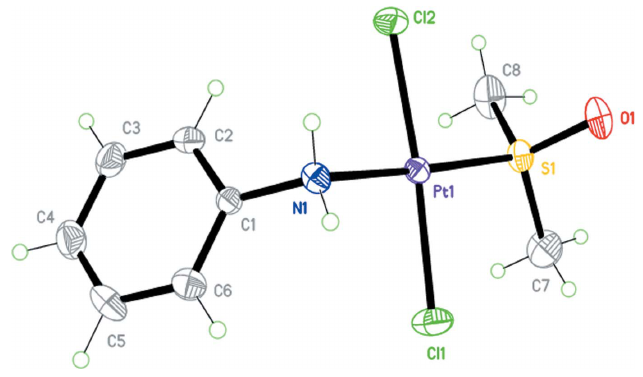
Figure 1 A view of the title compound with 30% probability displacement